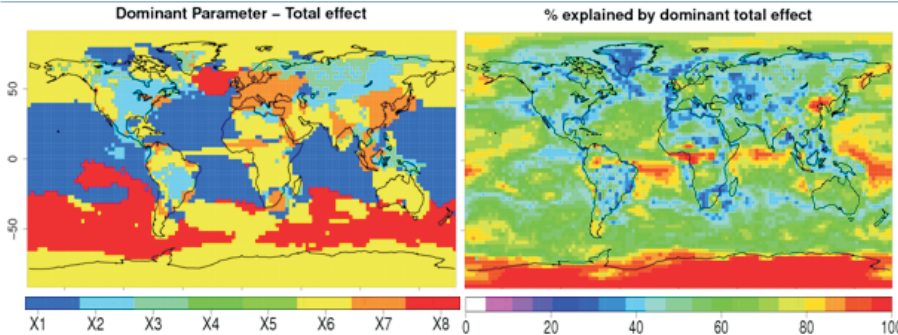
Fig. 8. The dominating total effect in each model gridbox and the percentage of July 2000 CCN variance explained by